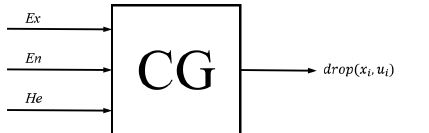
Figure 9. Schematic diagram of the forward cloud